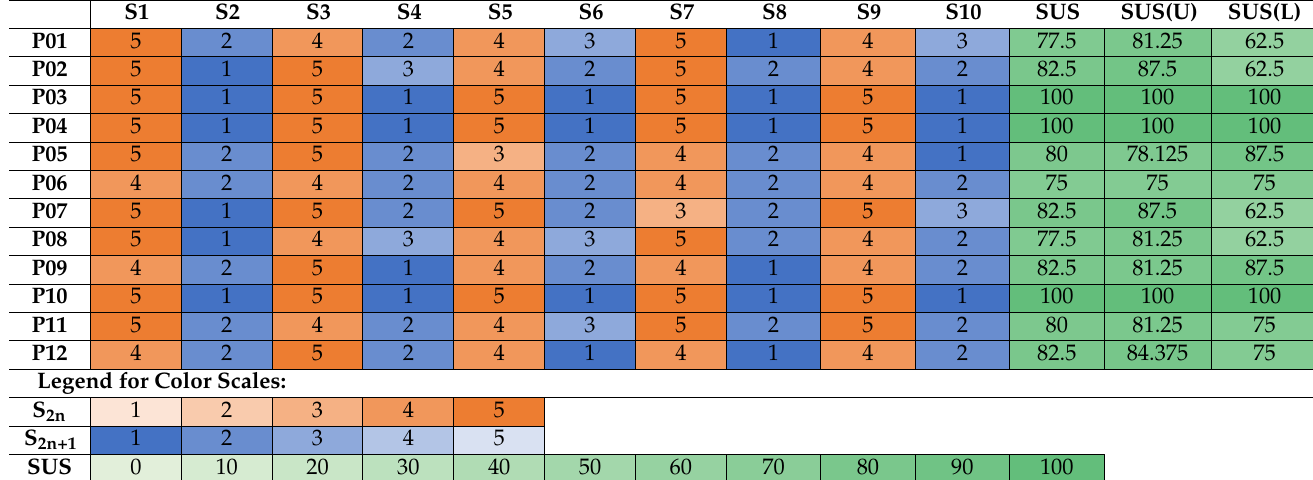
Table A7. Results of the application of the SUS questionnaire to 12 post-stroke patients at